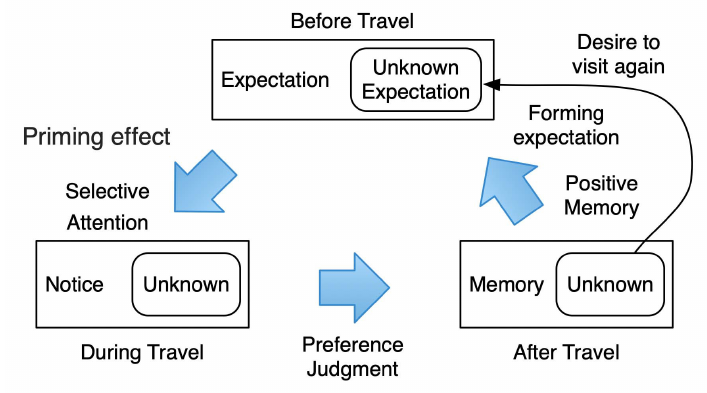
Figure 6. Cognitive model for